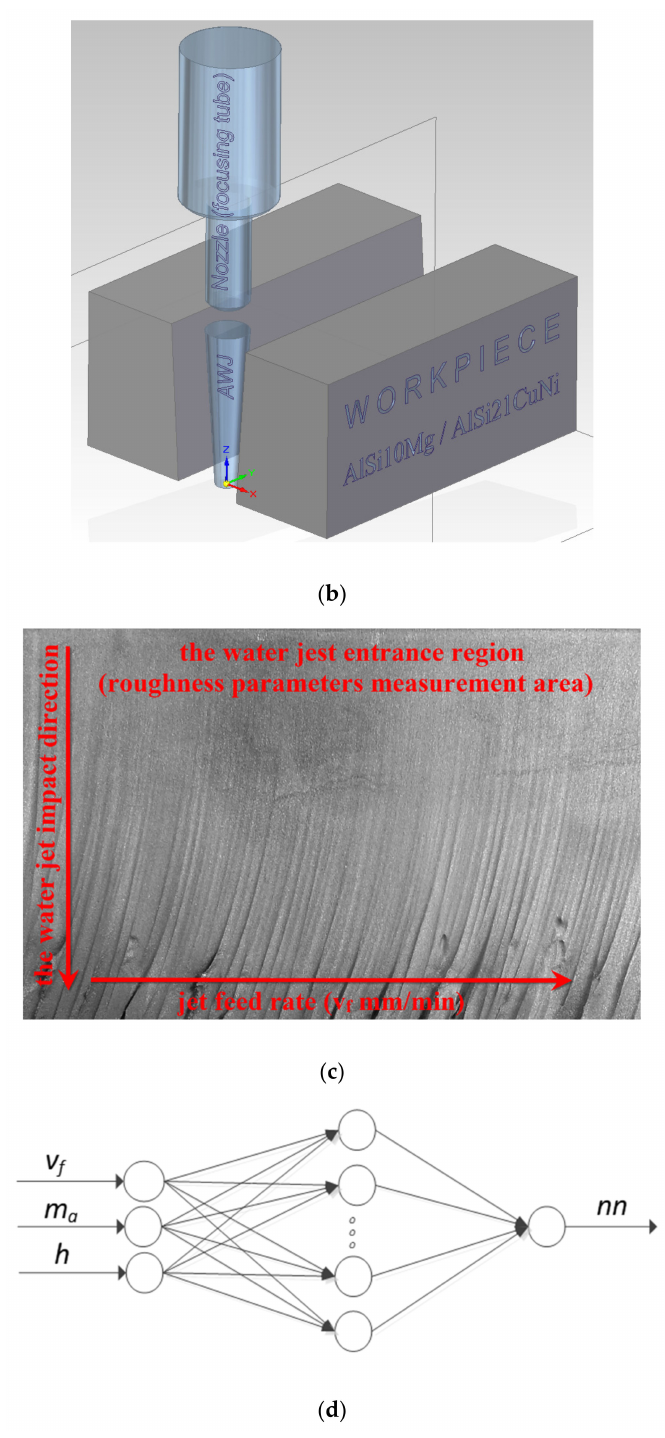
Figure 1. Schematics of ( a ) test flowchart, ( b ) abrasive waterjet (AWJ) visualisation, ( c ) measurement roughness parameters area, and ( d ) neural network for surface roughness parameter prediction. ANOVA, analysis of variance; ANN, artificial neural